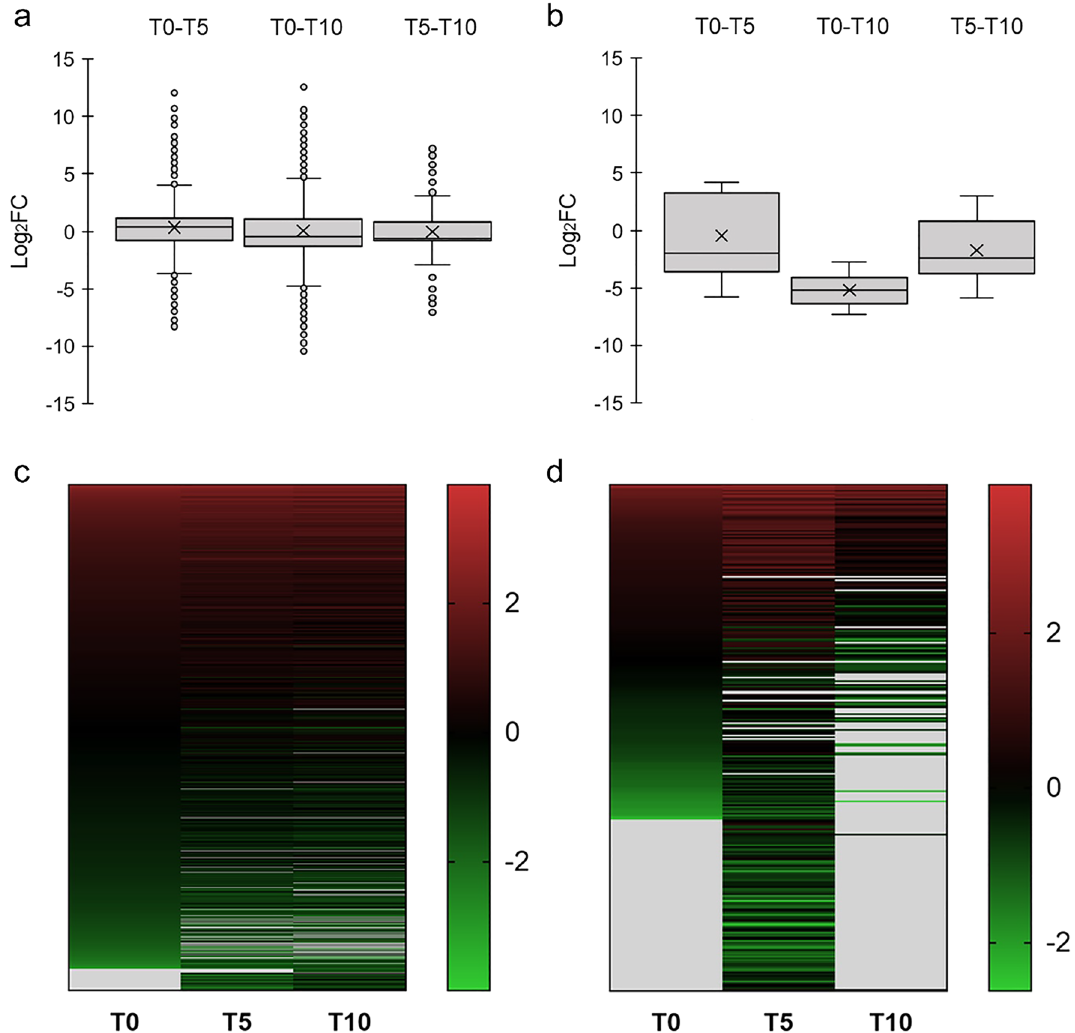
Figure 5. Statistically significant changes in the transcriptome and proteome in F. hepatica eggs at different points of development. The box plots provide an overview of transcriptome ( a ) and proteome ( b ) variability in different sample pairs. Transcripts and proteins with the most prominent changes in gene expression levels are located the furthest from zero on the y-axis. The heat maps show a global overview of changes in RNA levels of differentially expressed genes ( c ) and differentially translated proteins ( d ) at single gene/protein resolution. The gene/protein ranking is based on relative abundance detected at T0, with the most abundant transcripts appearing at the top of the heat map (red) and those with the lowest abundance appearing at the bottom (green). Differences in the expression/translation are given as Z-score values. Genes which were not expressed at a particular time point are presented in